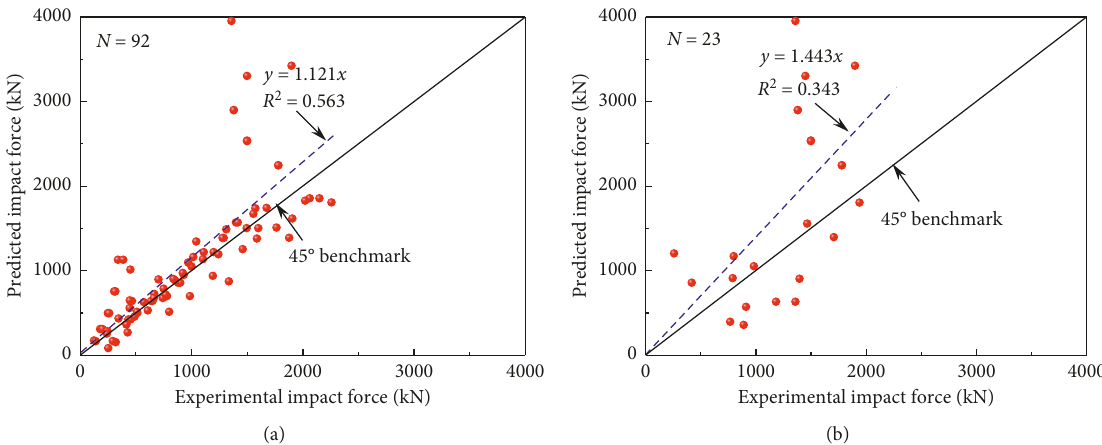
Figure 14: Comparison of experimental and predicted peak impact force using the existing method [3]. (a) Spherical nose. (b) Flat nose.